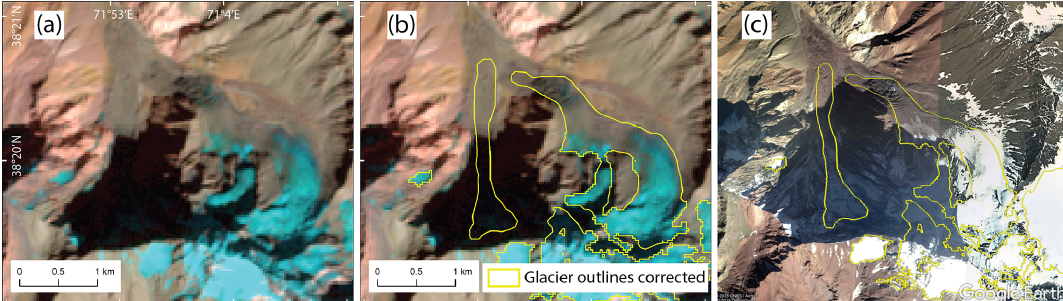
Figure 5. Glacier detection in shadow with the supporting input of high-resolution Google Earth images.